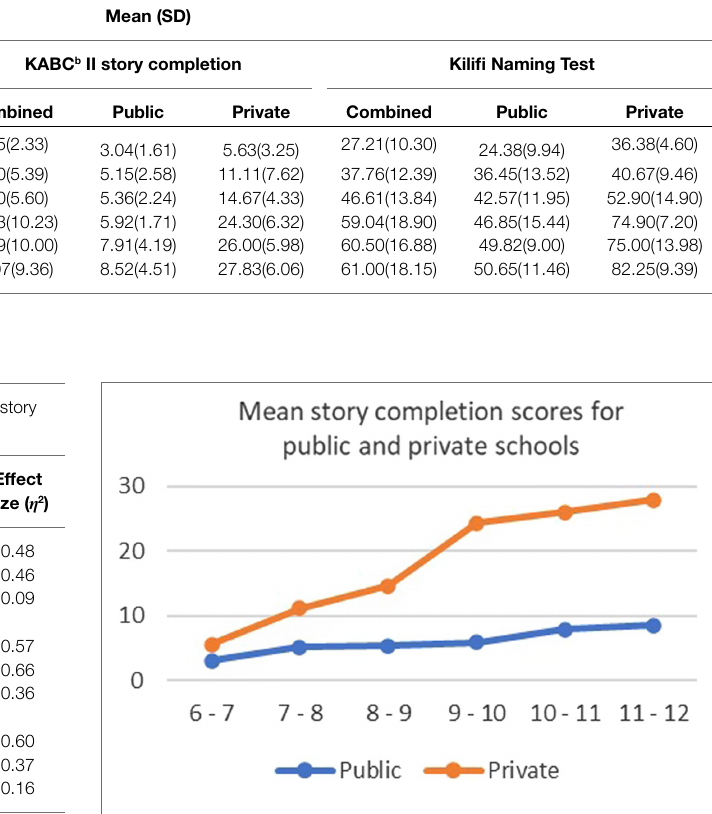
FIGURE 2 | Graph showing mean scores on KABC II story completion test for age groups by public and private schools.